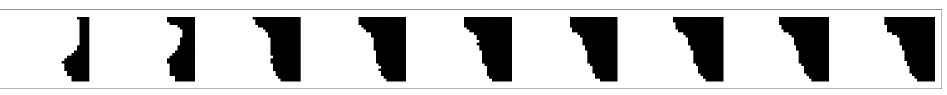
Figure 12. Evolution of decoded geometries during optimization, showing one frame every 10 opti- mization steps.